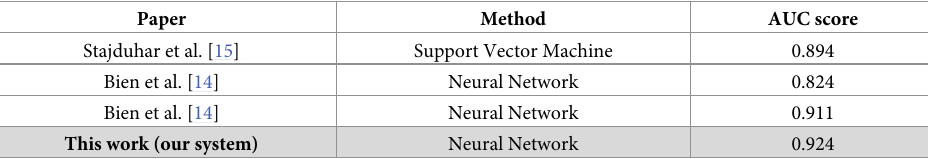
Table 3. Area-under-the-curve (AUC) scores of learning methods on MRI datasets.